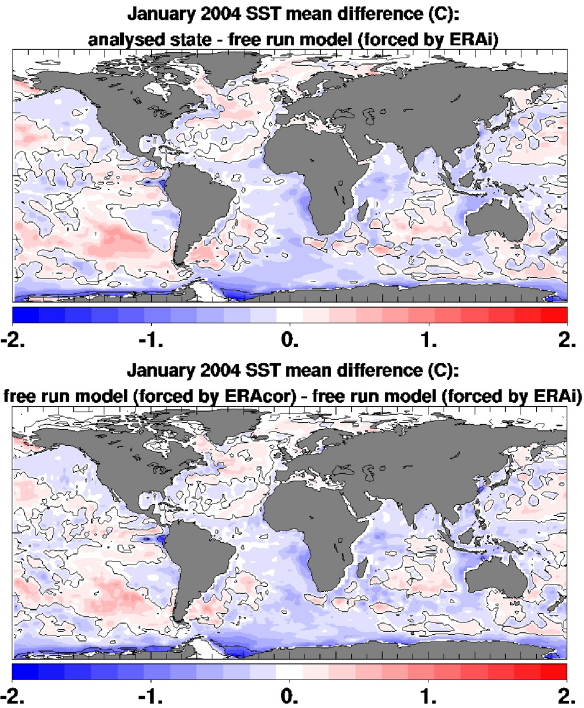
Fig. 3. SST differences between the free model run forced by ERAi and the result of the analysis step (top), and between the free model run forced by ERAi and the free model run forced by ERAcor (bot- tom) for January